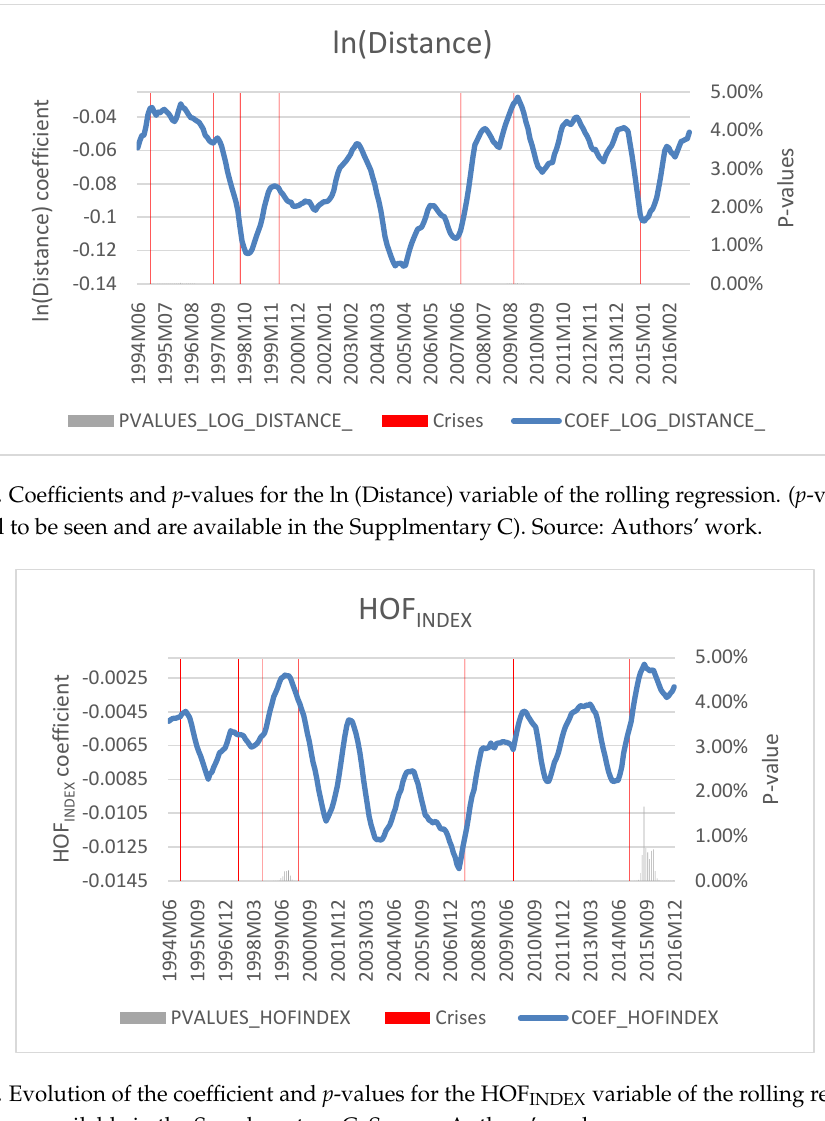
Figure 2. Coefficients and p -values for the ln (Distance) variable of the rolling regression. ( p -values are too small to be seen and are available in the Appendix C). Source: Authors’ work.